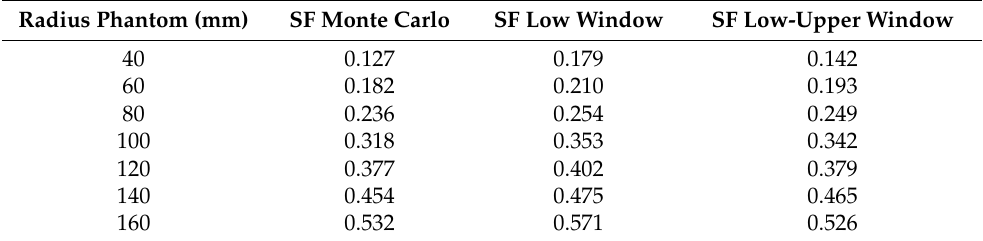
Table 2. Scatter fraction obtained by Monte Carlo simulations and by the proposed method. A water cylinder with different radii and the same activity source was simulated. Radius Phantom (mm) SF Monte Carlo SF Low Window